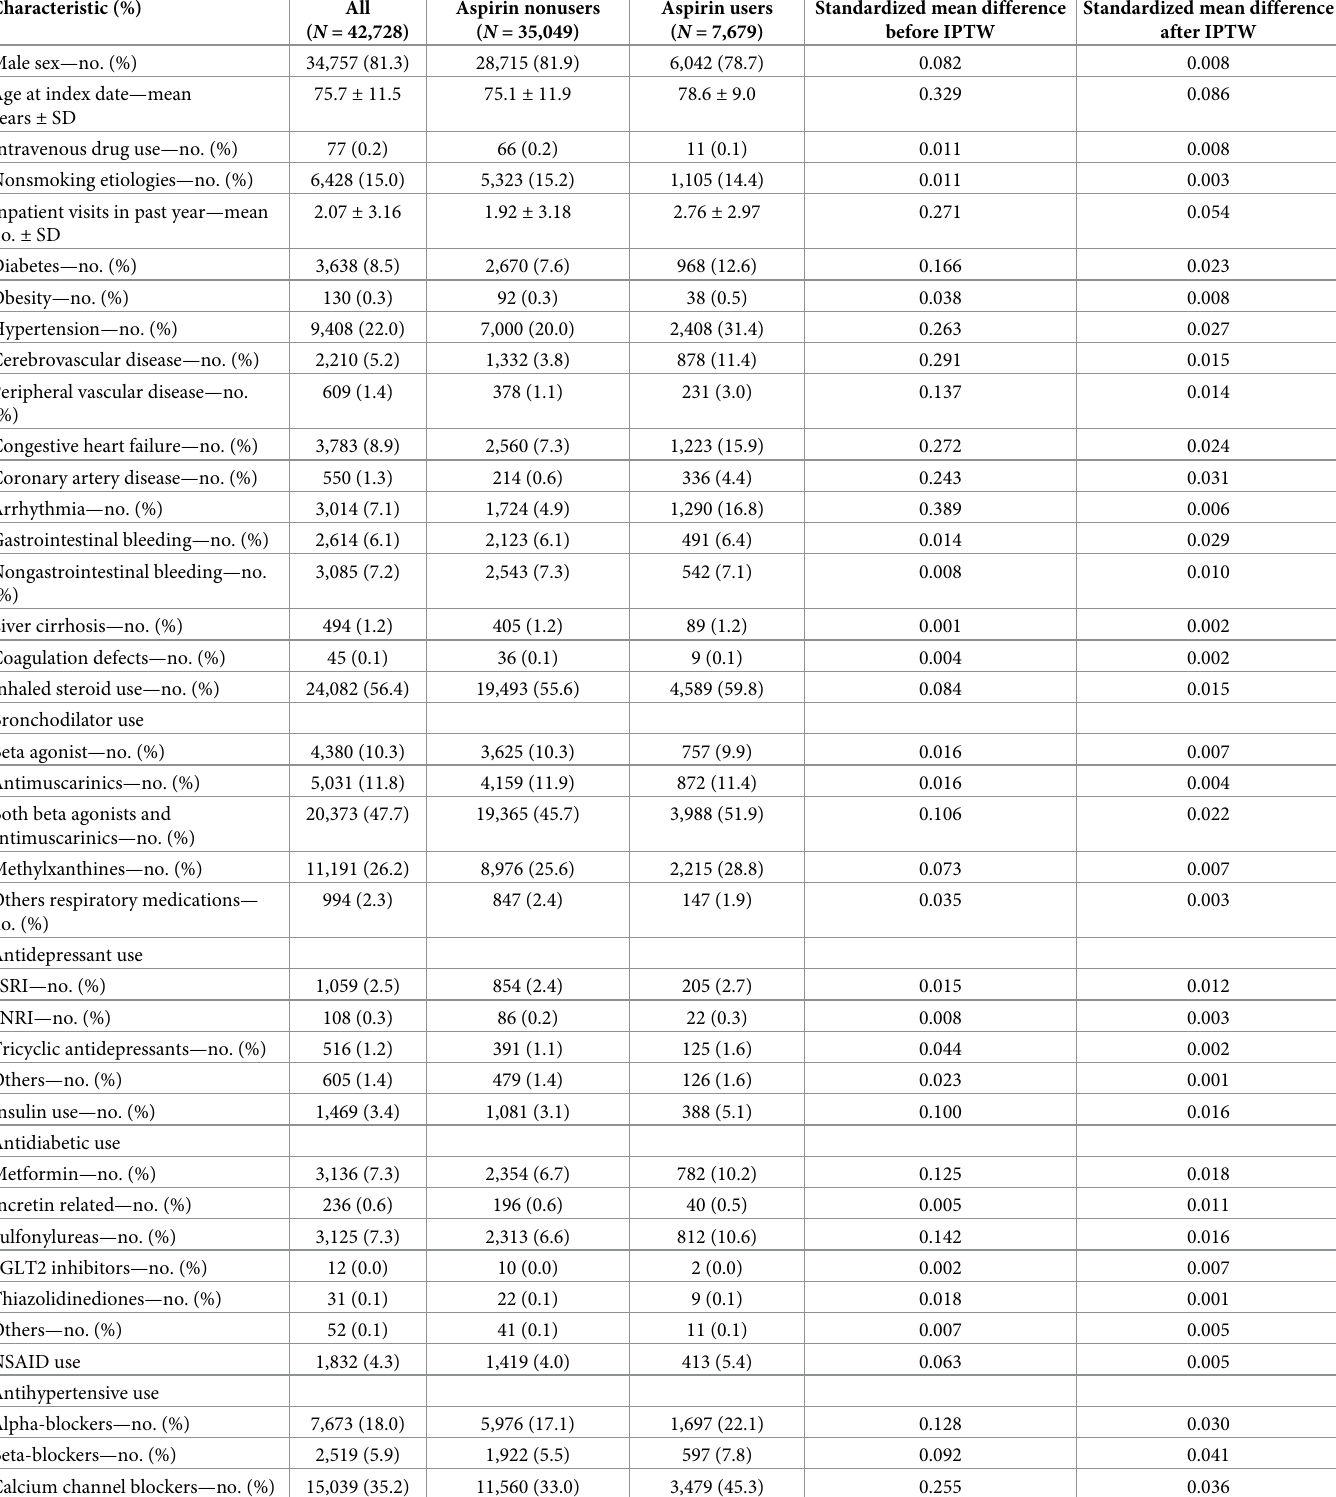
Table 1. Baseline characteristics of the study cohort, including their standardized mean difference before and after inverse propensity of treatment weighting. Characteristic